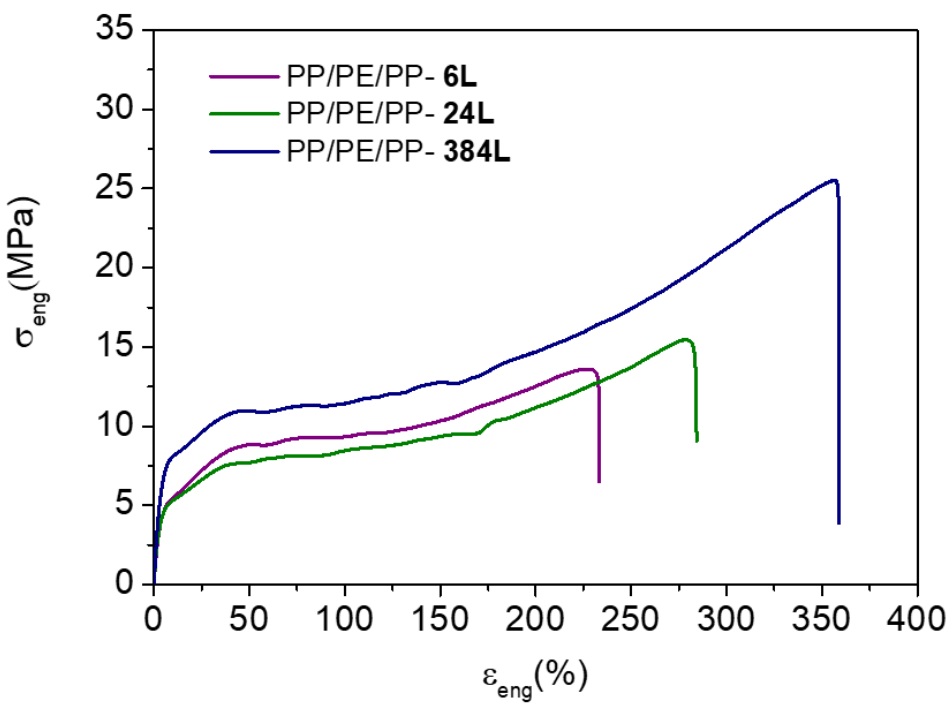
Figure 2. Engineering stress-strain plot of the PP/LLDPE/PP multilayer films with different numbers of layers in the machine direction (MD). Table 3. Tensile strength properties in the machine direction (MD) of the PP/LLDPE/PP and PP/LLDPE + EOC/PP multilayer films with different numbers of